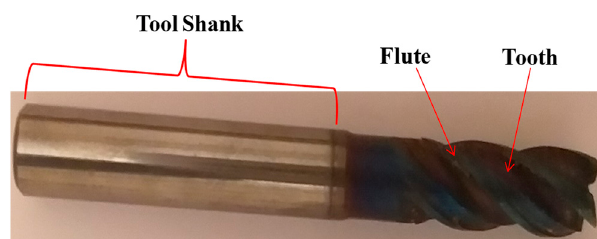
Figure 1. End-mill used in the experiments. Table 2. Experimental factors and their levels.